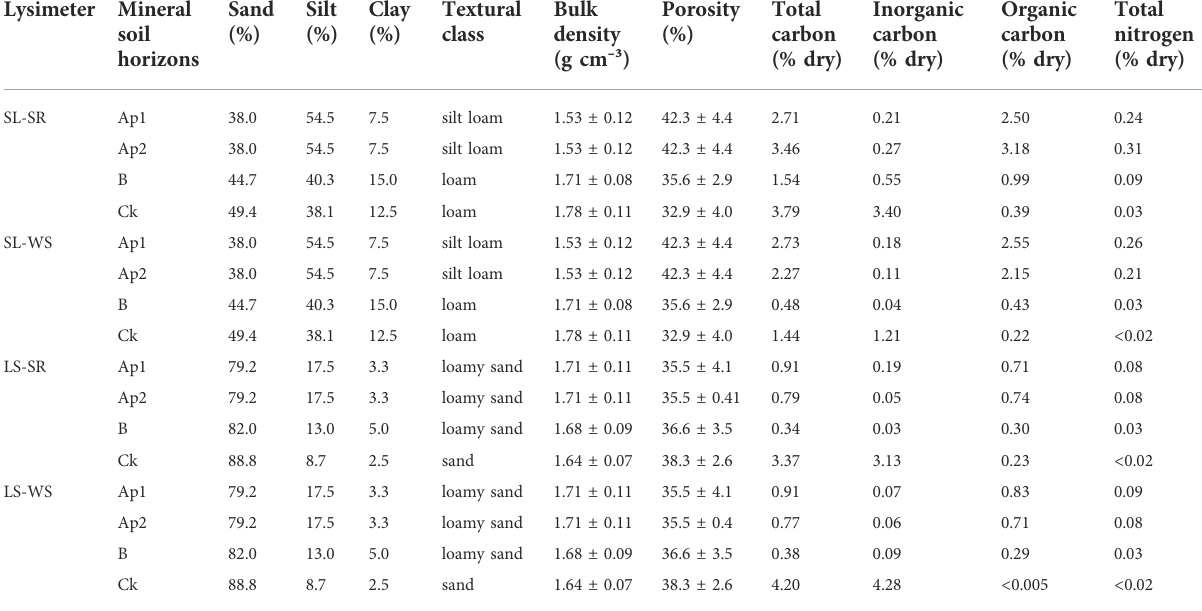
TABLE 1 Physical and chemical properties of the soil in the four lysimeters (Brown, 2021). Lysimeter Mineral soil